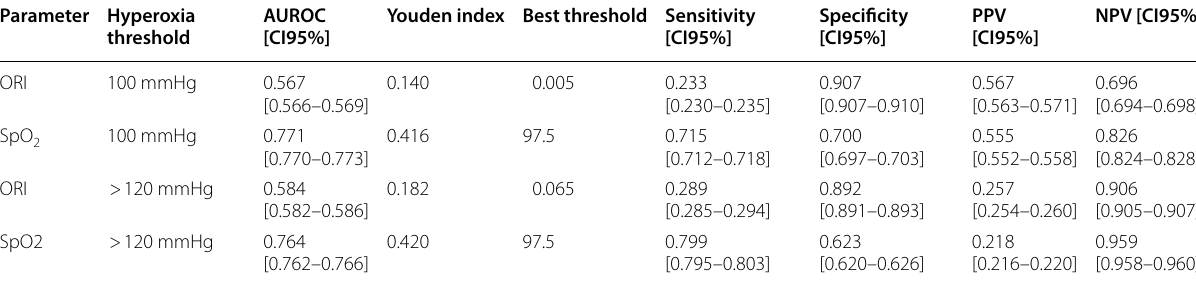
to detect PaO > 100 mmHg and PaO 2 2